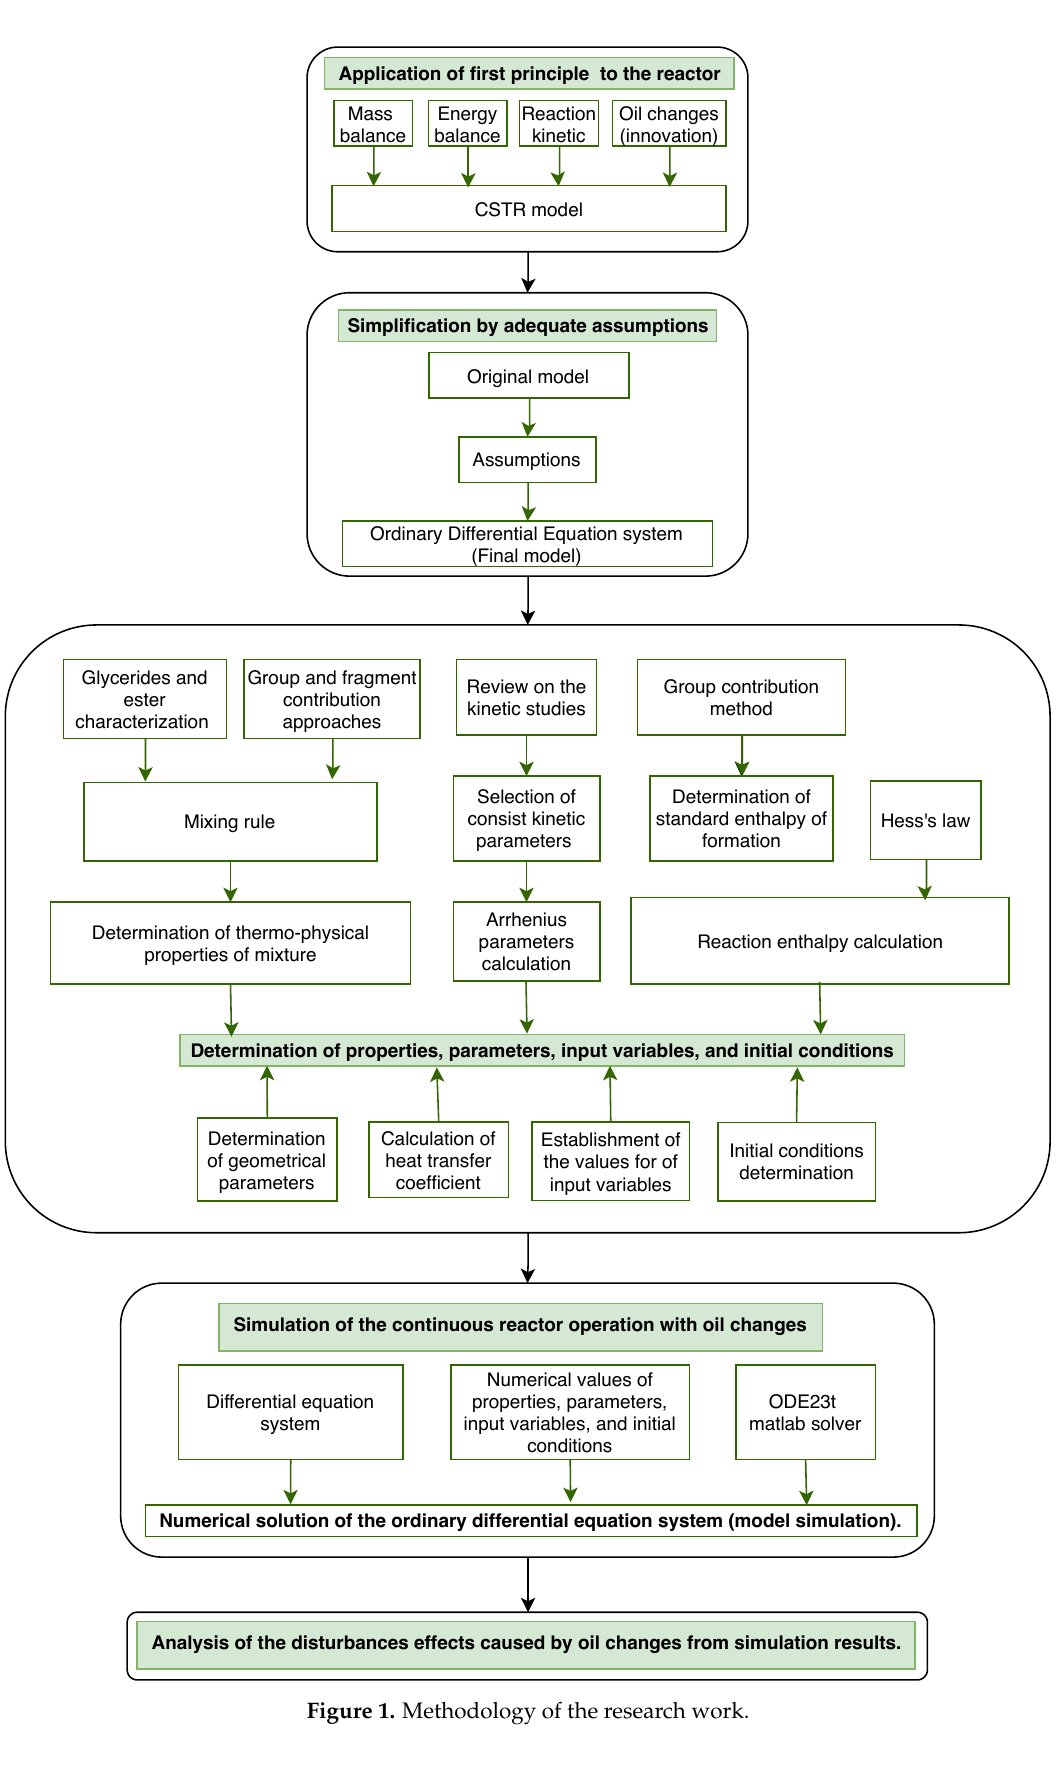
Figure 1. Methodology of the research